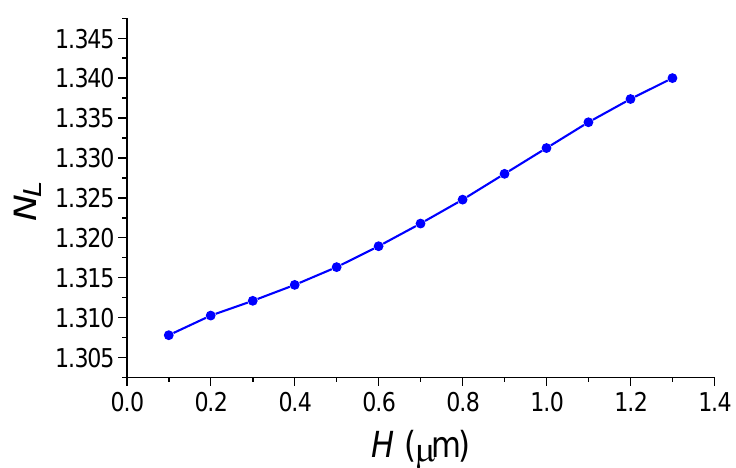
Figure 10. Dependence on the segmented width H of the mode index of the virtual leaky wave. M = 256, W = 1.0 µm. Simulation made by 2D FDTD.